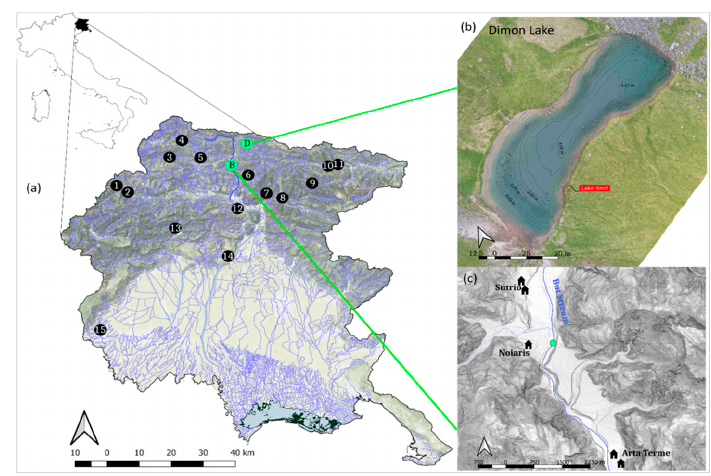
Figure 1. Location of the analyzed watercourses in Friuli Venezia-Giulia Region to verify if hepatic steatosis is or not normally present in the European bullhead ( a ); location of the Dimon Lake (46°34 ′ 05.4 ″ N; 13°03 ′ 45.8 ″ E) and But Stream (46°29 ′ 55.08 ″ N; 13° 0 ′ 3.59 ″ E) in Friuli Venezia-Giulia, northeast Italy ( a ); bathymetric profile of Dimon Lake ( b ); detailed location of the But Stream site ( c ). Figure ( b ) is kindly provided by GeoStudio RC (Giaveno, Italy). Table 1. Map code (Figure 1a), name, latitude, longitude and elevation of selected watercourses in Friuli Venezia-Giulia Region (northeast Italy). The liver alteration score (range 0–3) observed in Cottus gobio sampled during summer 2019 is also reported. Liver alteration: 0—not observed; 1—mild; 2—moderate; 3—severe.